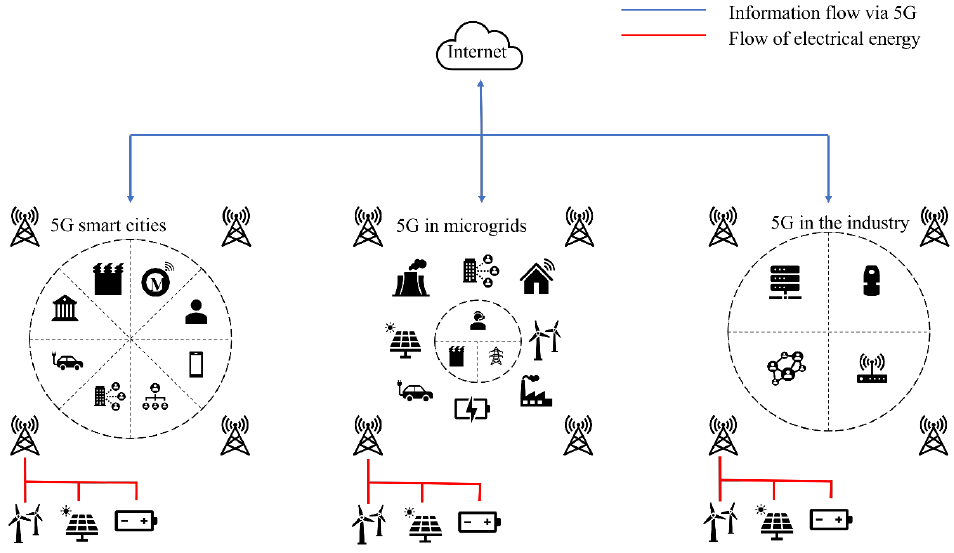
Figure 8. 5G applications within the microgrid.